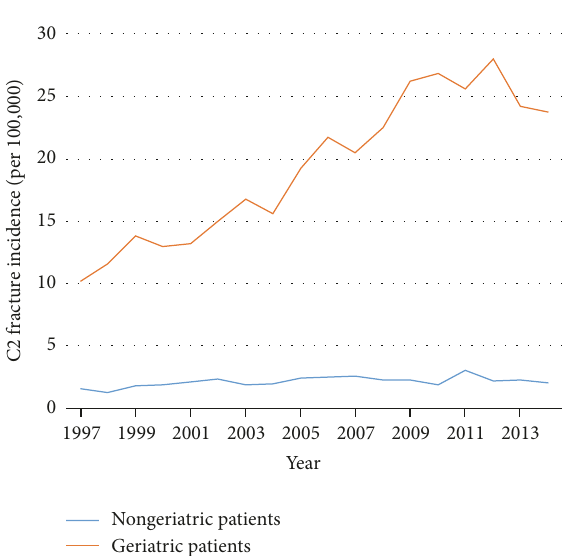
Figure 2: C2 fracture incidence per 100,000 of nongeriatric (blue) and geriatric (red) patients between 1997 and 2014.